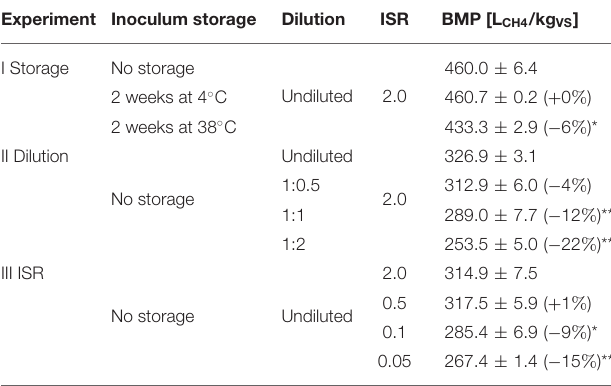
TABLE 2 | Summary of conducted experiments and achieved BMP (mean ± standard deviation, n = 3 bottles per condition, percentage in brackets provides the difference from the reference